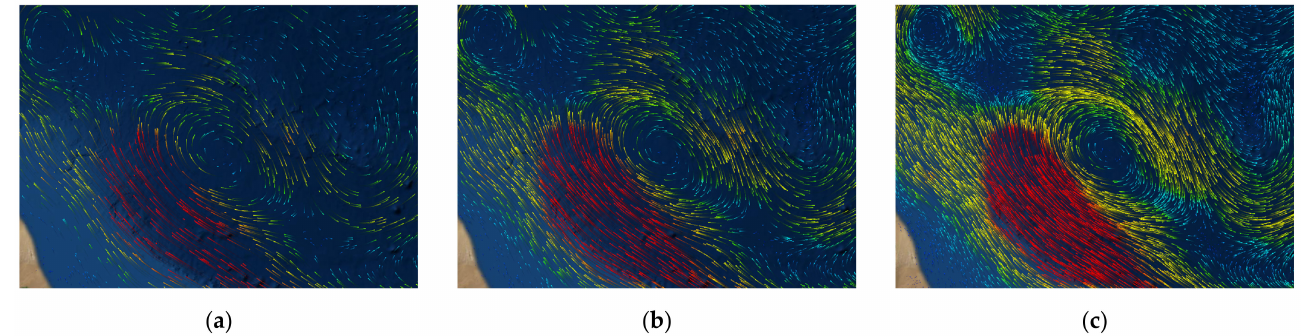
Figure 11. Current data representation generated by different visualization methods at the viewing distance of 2000 km. ( a ) is the rendering for the direct visualization method; ( b ) is the rendering for the geometric visualization method; and ( c ) is the rendering for the dynamic streamlet method based on the particle